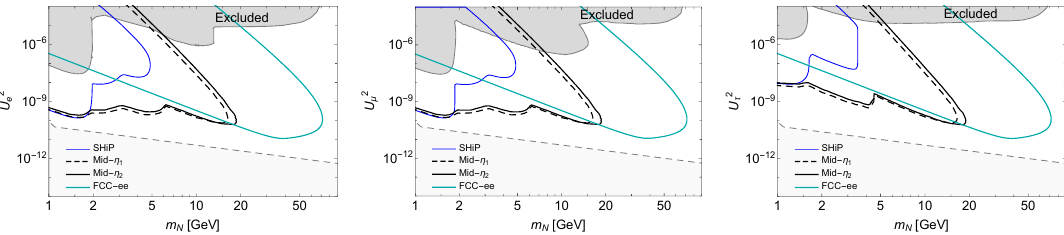
Figure 9 . Sensitivity of mid- η configurations to HNLs with different mixing patterns: pure e , pure µ , pure τ . For reference, the sensitivity regions of FCC-ee and SHiP are also shown. The assumptions are the same as in figure